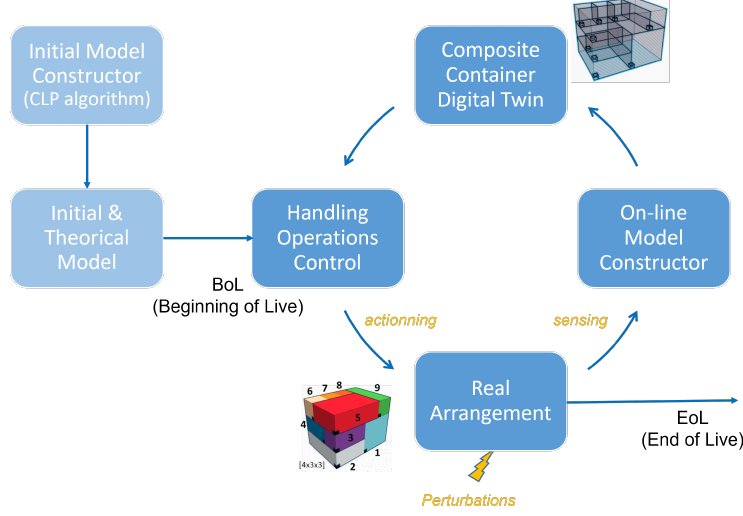
Figure 1. Life cycle of real arrangement and its digital